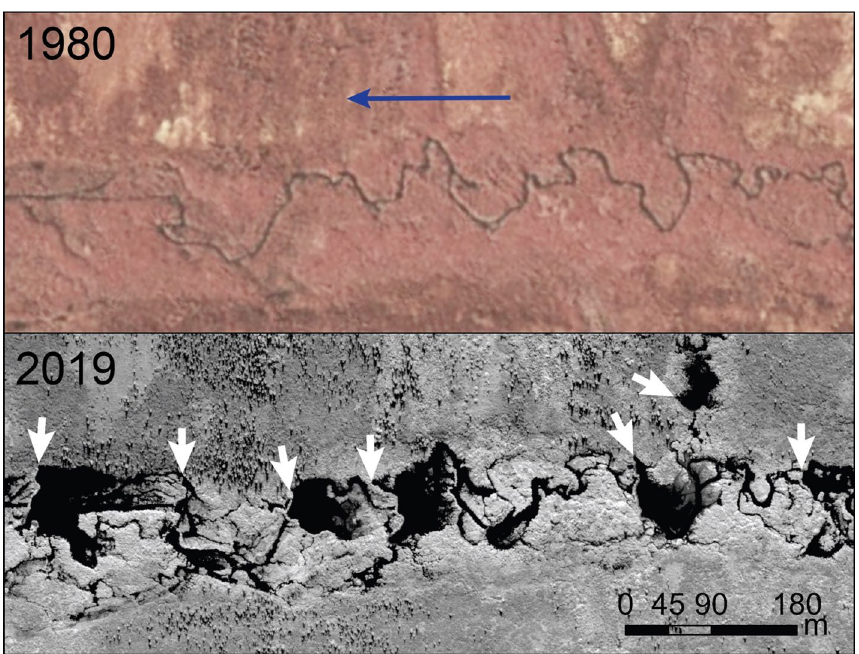
Figure 1. Beaver colonization and engineering in tundra. 1980 color infrared aerial photography and 2019 Worldview satellite image (© 2022 Maxar, Inc.) showing construction of beaver dams and formation of ponds along a tundra stream near the treeline on the Seward Peninsula. Blue arrow indicates stream flow direction; black ponds are all bound by dams on the downstream ends; white arrows denote some prominent ones.